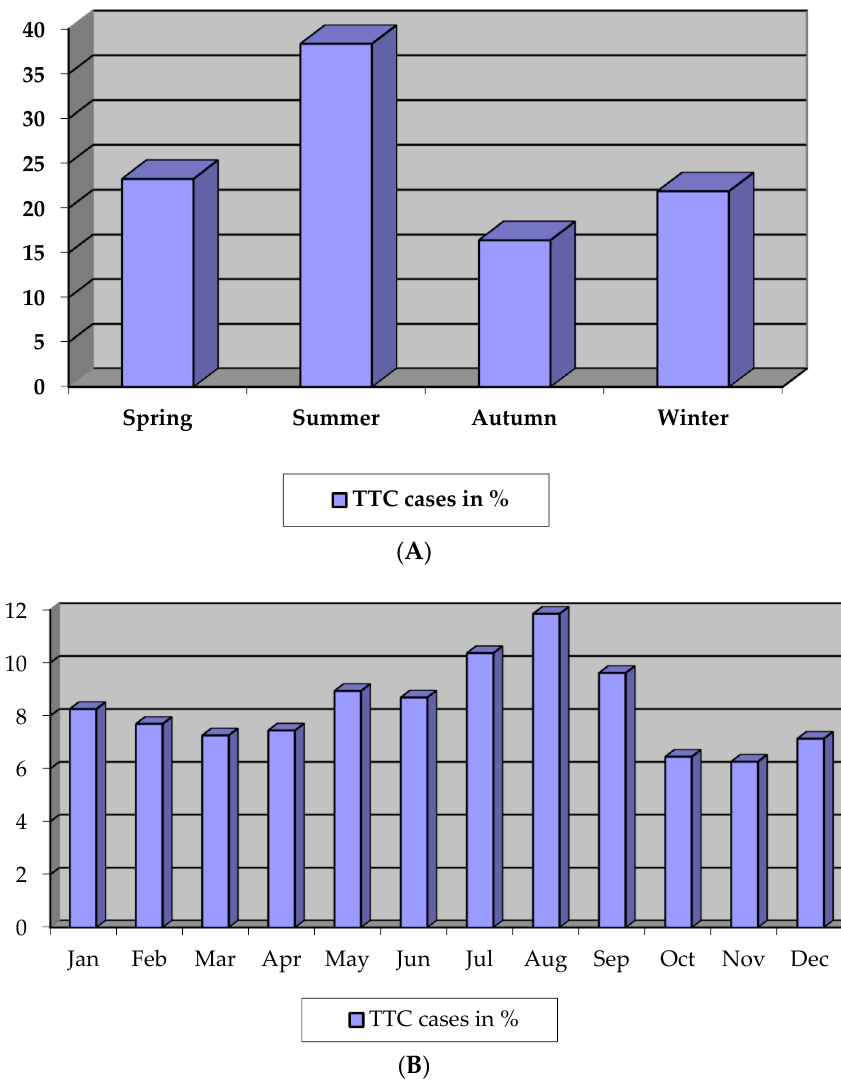
Figure 3. ( A ) Seasonal variation of TTC (total = 537 cases), ( B ) Monthly variation of TTC (total = 537 cases).